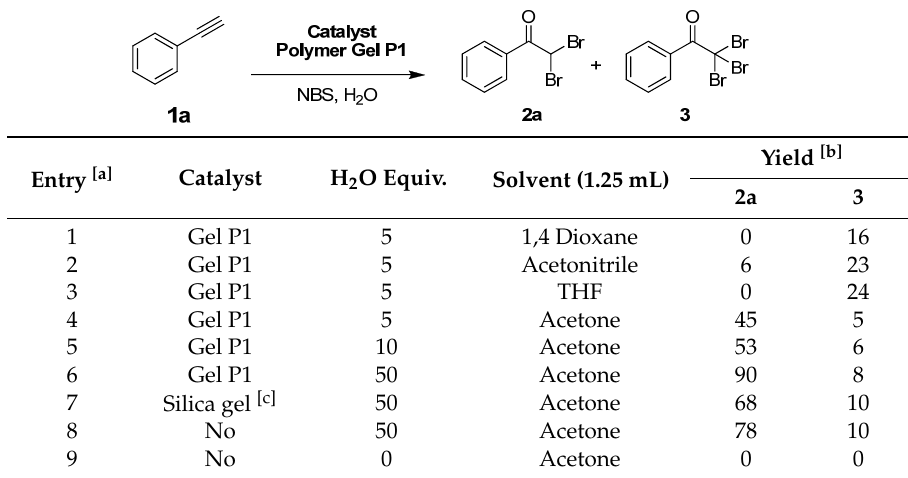
Table 1. Optimization of reaction conditions for the synthesis of α , α -dibromoketones.